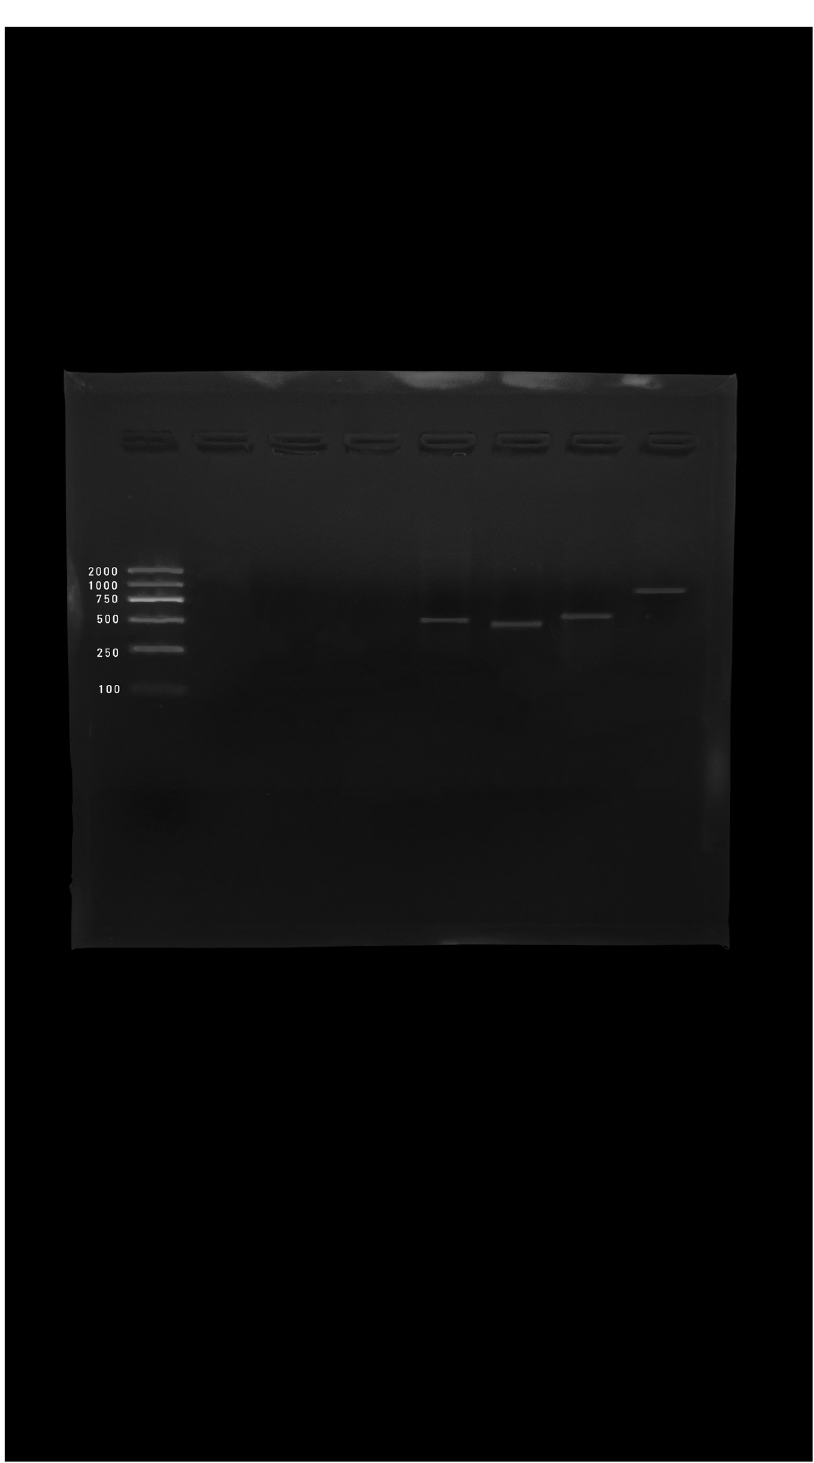
Fig 1. PCR product of raw water sample s from MN-WWTP. (A) Lane 1: DNA ladder (100–2000 bp), Lane 2: negative control, Lane 3,4: negative samples, Lane 5: 476 bp ( Myoviridae , DGF primer), Lane 6: 459 bp ( Siphoviridae , MCF-2 primer), Lane 7: 500 bp ( Myoviridae , CTF primer) and Lane 8: 774 bp ( Podoviridae , MCF-3 primer).